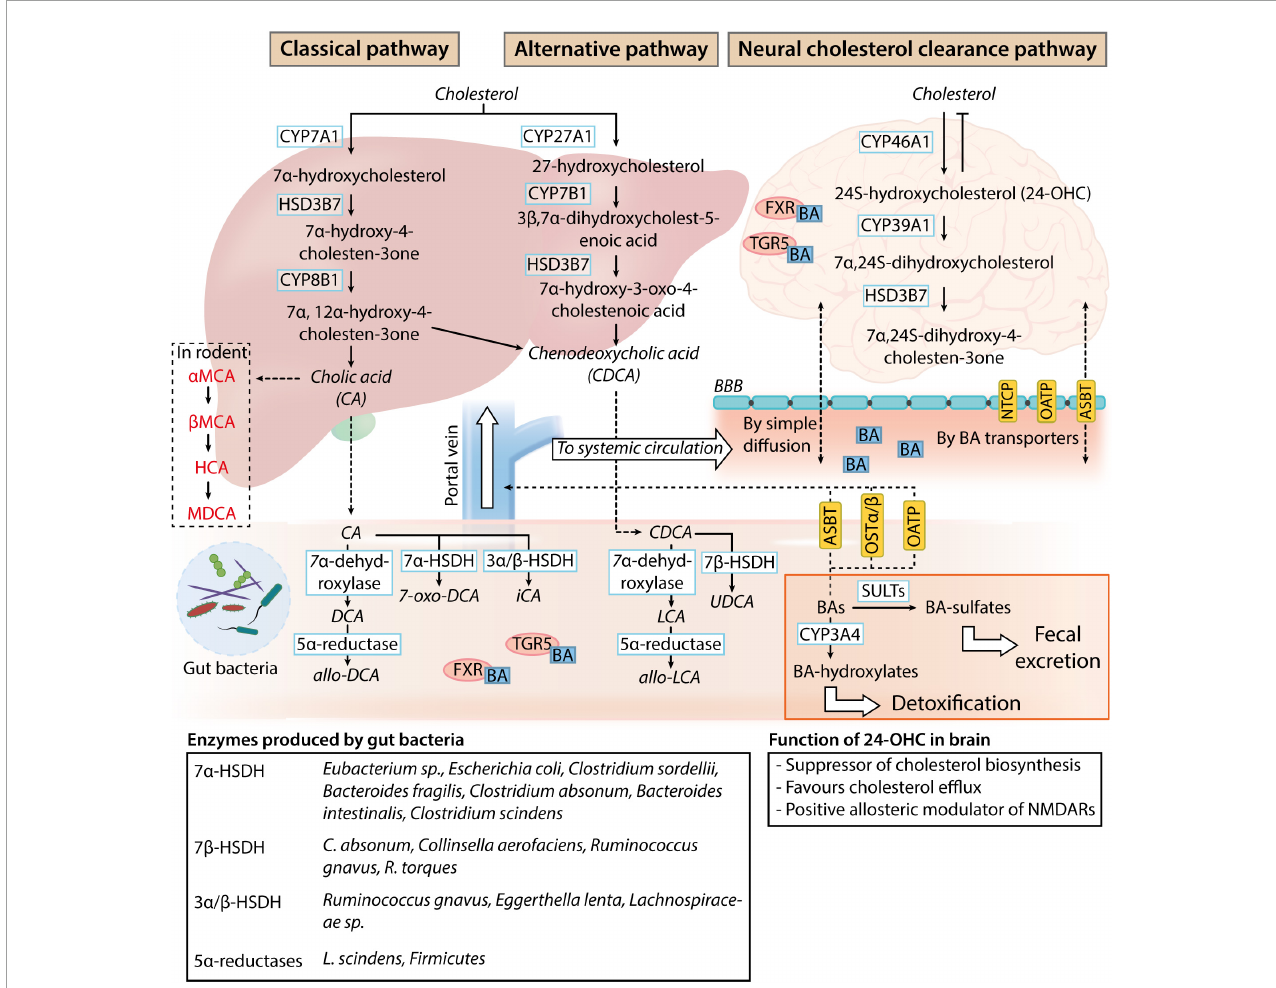
FIGURE1 Bile acid metabolism and circulation. In normal physiological conditions, the classical pathway accounts for 90% of the bile acids (BAs) present in the human body. While BAs are produced as systemic modulators of physiological processes by the liver (classical and alternative pathways), sterols are produced as by-products of the brain cholesterol clearance process (neural cholesterol clearance pathway). Primary BAs produced by the liver are deposited in the gallbladder and released into the intestine upon stimulation by the hunger hormone cholecystokinin for lipid emulsification. Once in the gastrointestinal tract, primary BAs are readily deconjugated, dehydroxylated, or dehydrogenated by gut microbes. The main bacterial enzymes involved in the process are listed in the table at the bottom of the image. These modified BAs (secondary BAs) can proceed to exert their effects as a negative modulator of gut function through bile acid receptor pathways [Takeda G-protein-coupled receptor 5 (TGR5) and farnesoid X receptor (FXR) signaling] or gut microbiome composition. After which, BAs can be passively reabsorbed into the liver for further conjugation with taurine or glycine and enter the systemic circulation and the central nervous system through simple diffusion or BA transporters present on the blood-brain barrier (NTCP, sodium taurocholate co-transport peptide; OATP, organic anion transporting polypeptides; ASBT, apical sodium bile acid transporter). 24-hydroxycholesterol (24-OHC) produced by the neural cholesterol clearance pathway negatively regulates cholesterol metabolism in the brain, while the physiological function of systemic BAs in the nervous system is unclear. BAs can be transported back into the intestine (ASBT, OATP, and OST α / β , organic solute transporter α , and β ) and further sulfated by sulfotransferase (SULT) or hydroxylated by Cytochrome P450, family 2, subfamily a, polypeptide 4 (CYP3A4) for detoxification or clearance through fecal